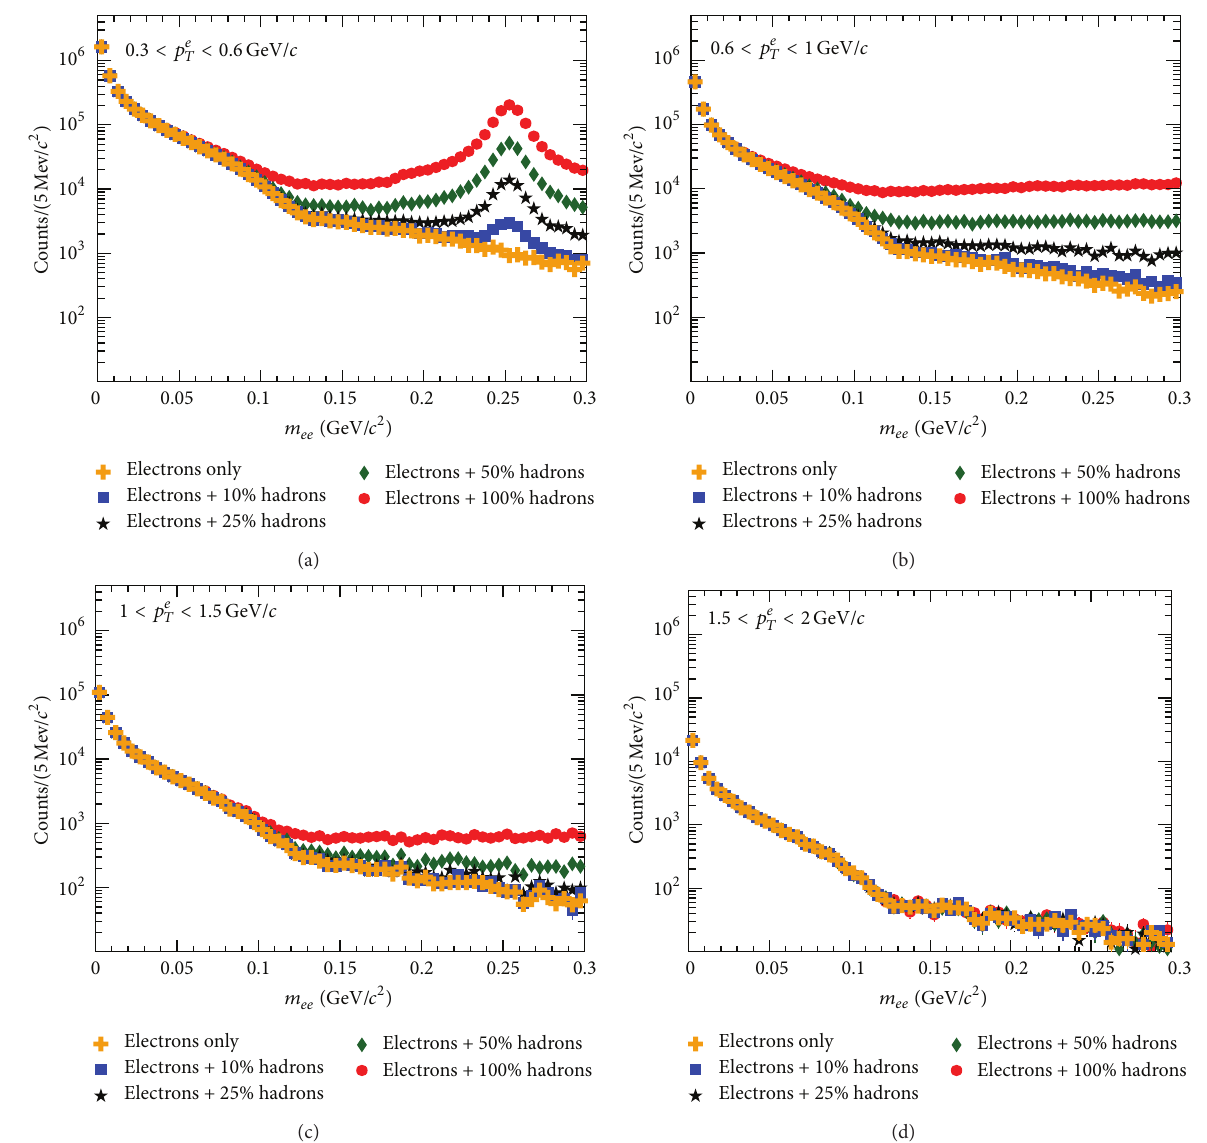
Figure 8: Dielectron mass spectra after combinatorial background subtraction for various hadron contamination levels. The peak around ∼ 0.26 GeV /𝑐 2 is a 𝜙 → 𝐾 + 𝐾 − that has been reconstructed with the wrong assumption about the daughter mass. 𝑚 𝑒 + 𝑒 −